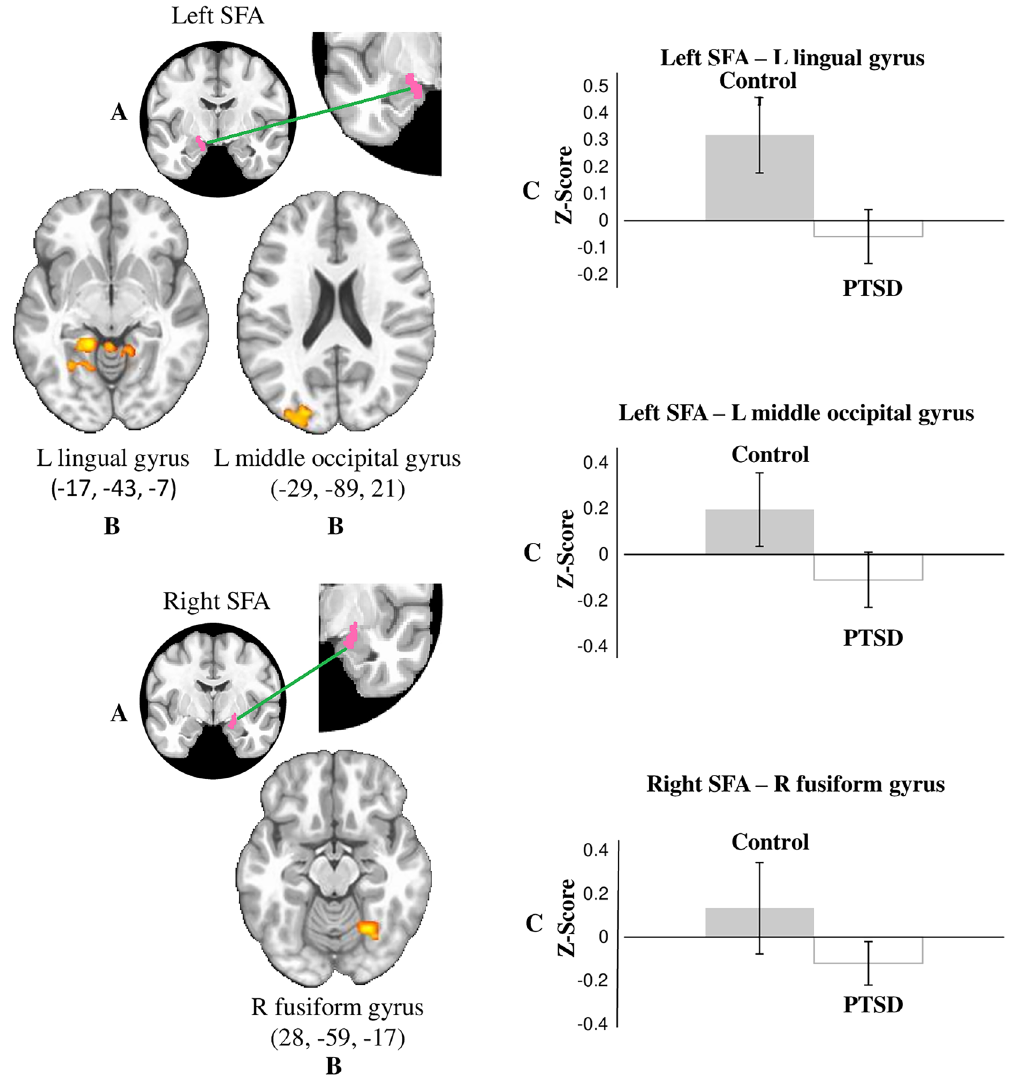
Figure 1. Areas of negative correlation between functional connectivity for left and right SFA and PCL-5 in the PTSD group. ( A ) Illustration of seeds, filled in pink (seed is magnified for better visualization); ( B ) overlays for the areas of the brain that showed significant association for the SFA, for PTSD PCL-5 scores (p < 0.05 corrected for multiple comparisons); ( C ) bar graphs show the values of the Z scores for connectivity between the regions shown in the overlays in ( B ). Standard error bars are shown for Z values.